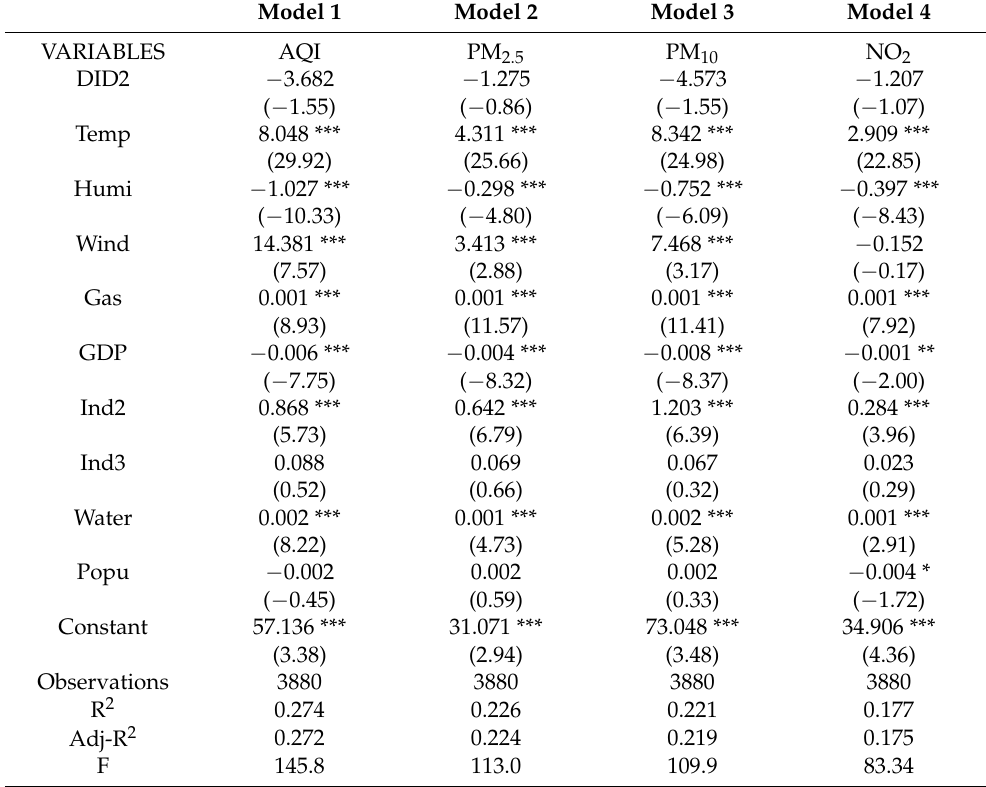
Table 8. Placebo test